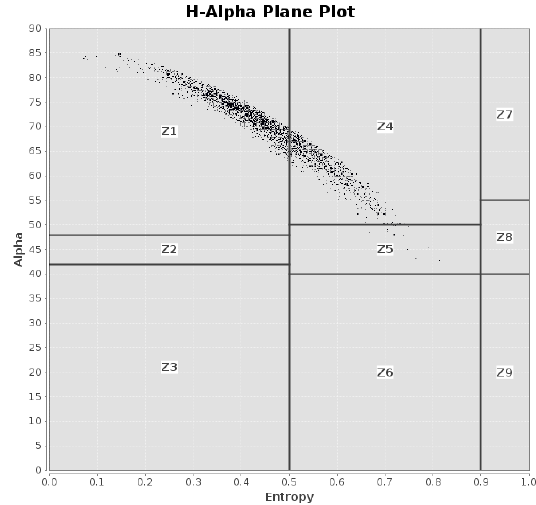
Figure 3: A Landslide(Goda Tabala) in H-Alpha